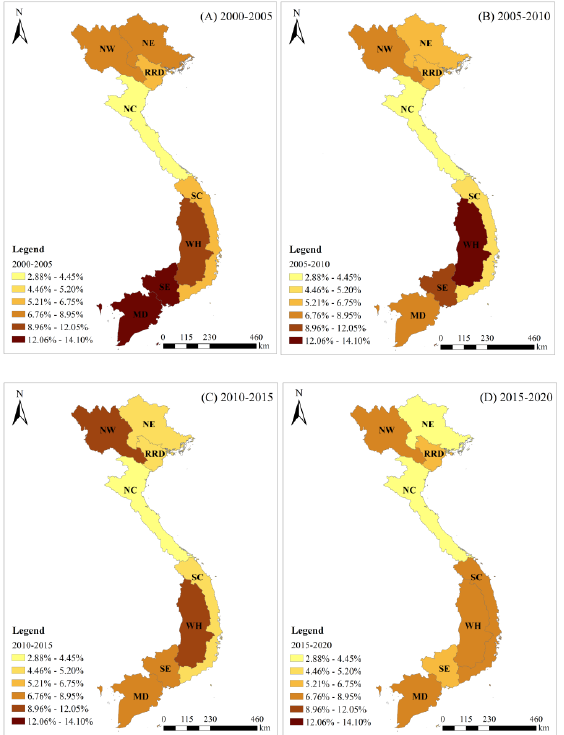
Figure 3. The spatial distribution map of integrated dynamic degree of LULC in Vietnam. ( A ), 2000–2005; ( B ), 2005–2010; ( C ), 2010–2015; ( D ), 2015–2020.